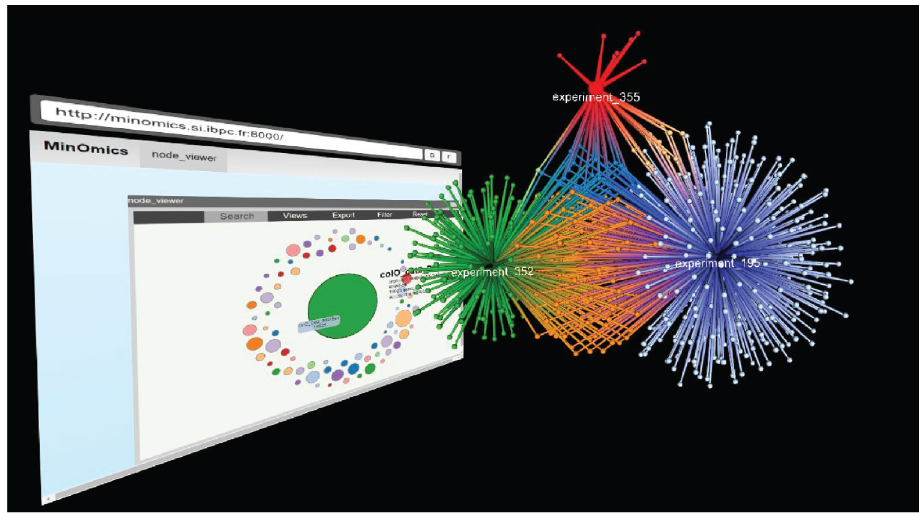
Figure 9: Example of a MinOmics webpage inside a Unity3D application. A similar embedding can be achieved inside a UnityMol application, where a web browser could render the MinOmics web page alongside the 3D molecular data or a proteomic network as illustrated